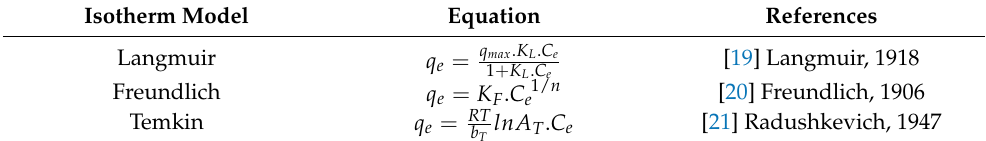
Table 4. Equilibrium models equations used to investigate crystal violet degradation mechanism.